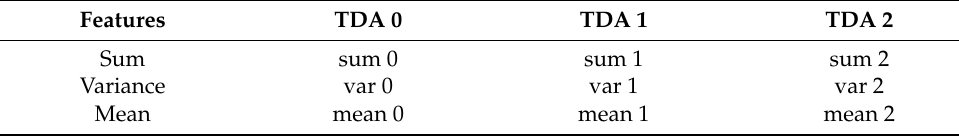
Table 2. Defined nine TDA